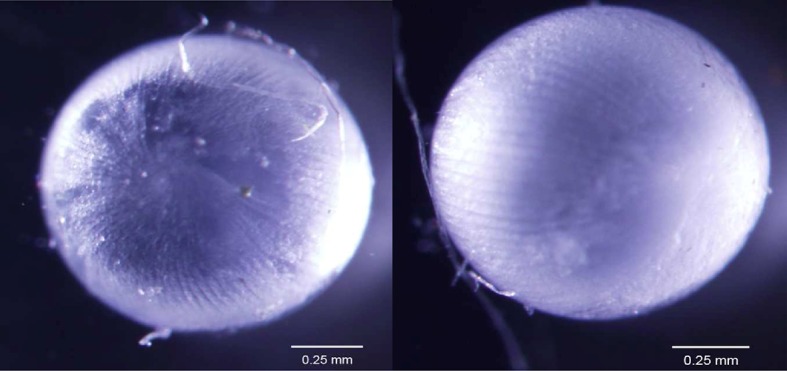
Lenses from #0 control (left) and #19 experimental (right) newts.Note that the size, fiber arrangement, and transparency of both samples are normal.